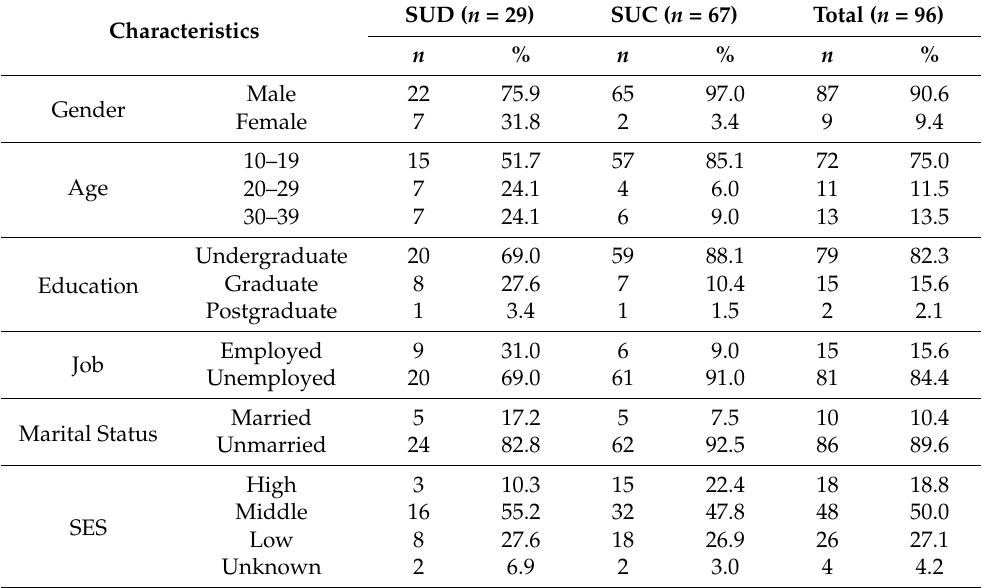
Table 2. Socio-demographic status of participants in the smartphone usage disorder (SUD) and smartphone usage control (SUC)